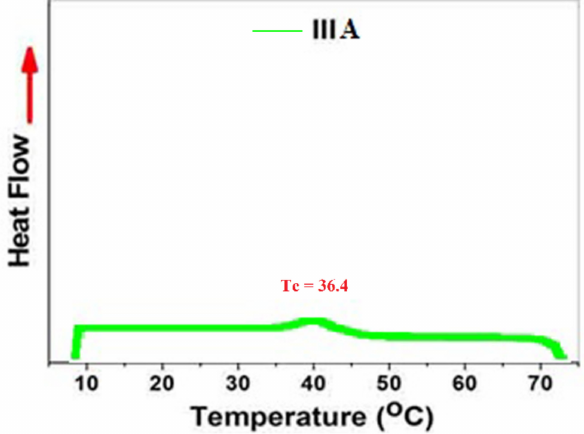
Figure 12. Micro-DSC of polymer solution ( IIIc ) for determination of LCST ( T c